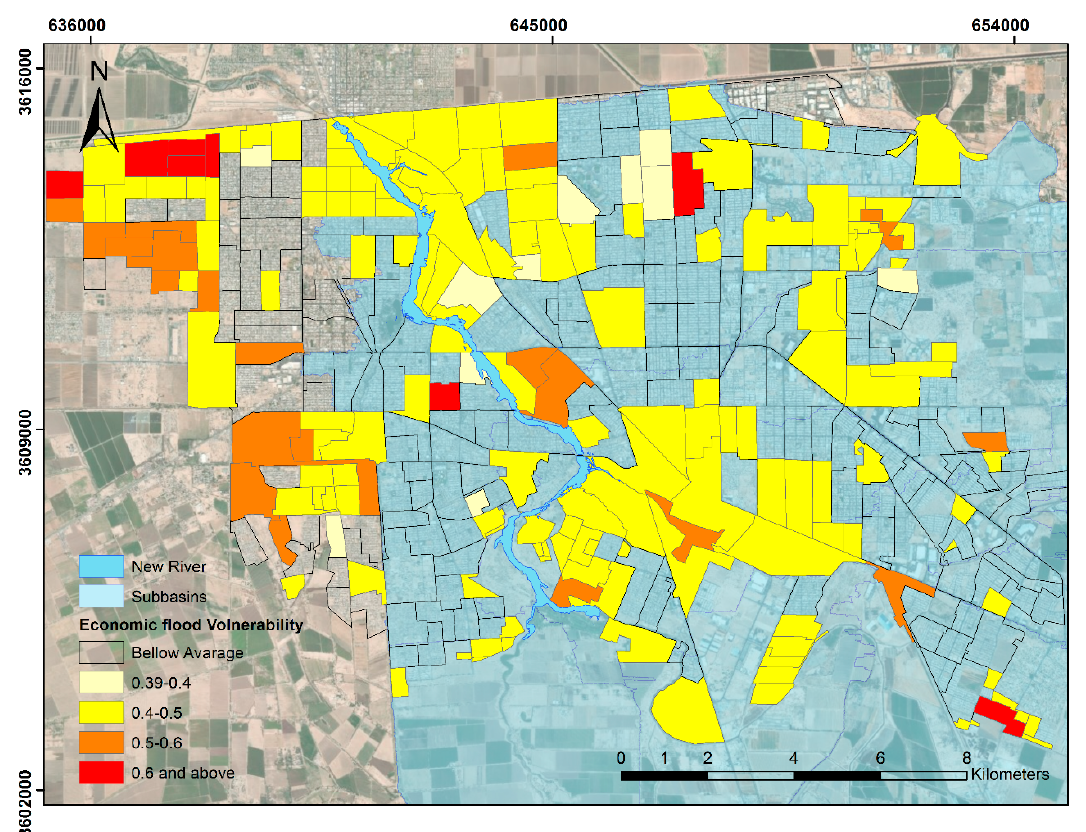
Figure 6. Spatial distribution of the AGEBS with a economic vulnerability above the average value.